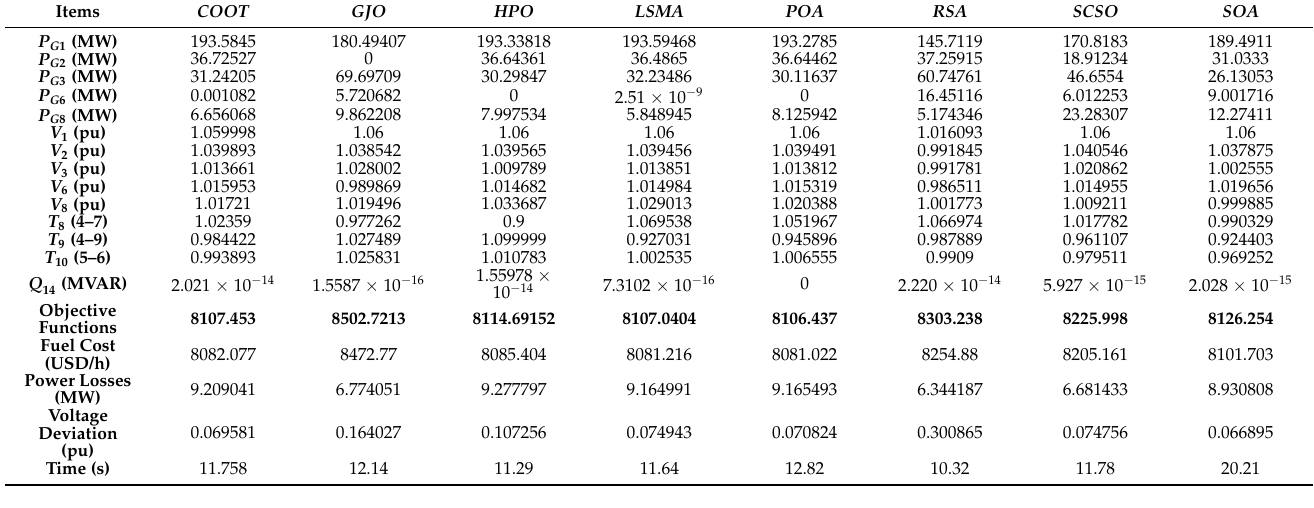
Table 6. Optimal control variables for the IEEE 14-bus test system for minimizing multi-objective function with emissions.